Question: Write a single sentence explaining what this figure depicts.
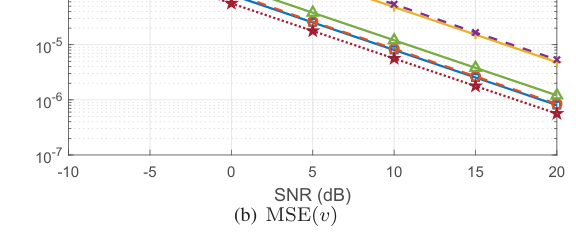
Answer: MSE versus SNR in the case of 2D array.